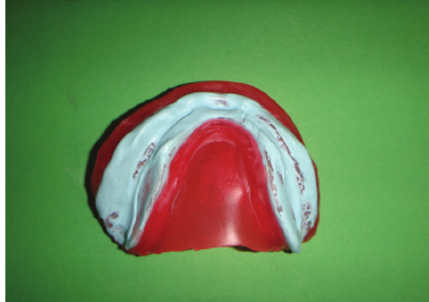
Figure 8: Beaded wash impression made with noneugenol zinc oxide